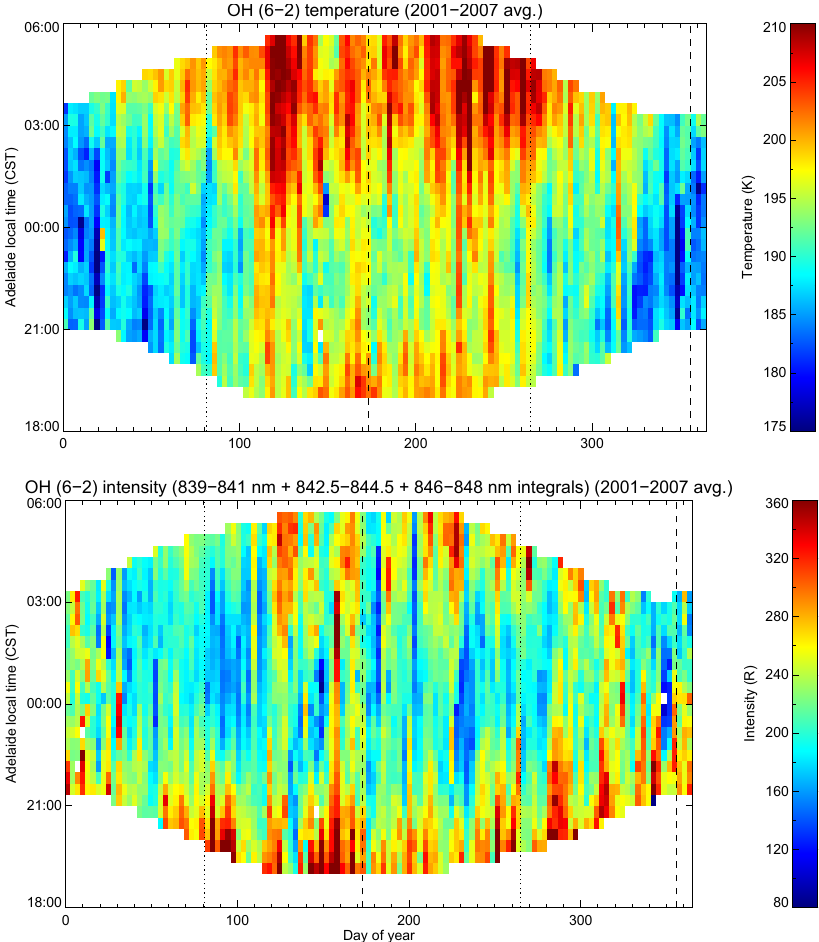
Figure 1. Top: the OH(6–2) temperature plotted as a function of time of day and time of year for a superposed year. The equinoxes are indicated by dotted lines, the solstices by dashed lines. Minimum temperatures are observed in summer, with a general increase in temperature between the equinoxes. During this period, the temperatures are greatest at dawn and dusk. There is a tendency for the temperature to be greatest between the autumnal equinox and the vernal equinox, with a semi-annual variation in temperature, which is strongest late in the night, although there is a mid-winter maximum present as well. Bottom: as for top panel but for the OH(6–2) emission